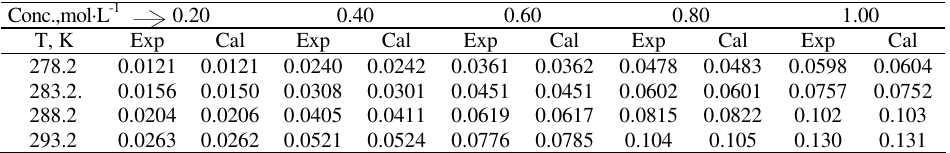
Table 3. The values of k experimental and calculated at different temperatures ([OH - ] obs =1.38 × 10 -4 mol·L -1 R= triethanolamine) Conc.,mol·L -1 0.20 T, K